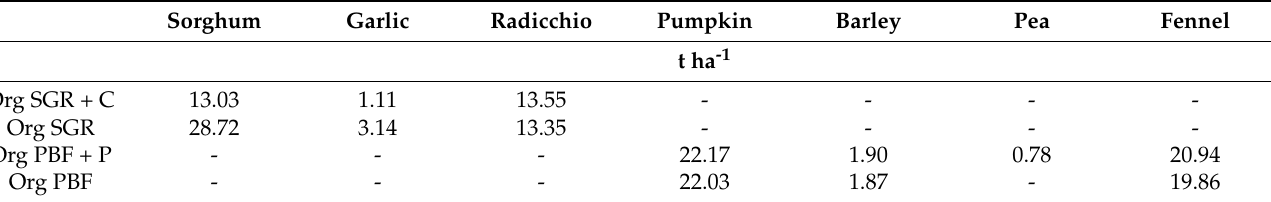
Table 3. Crops yield of Org